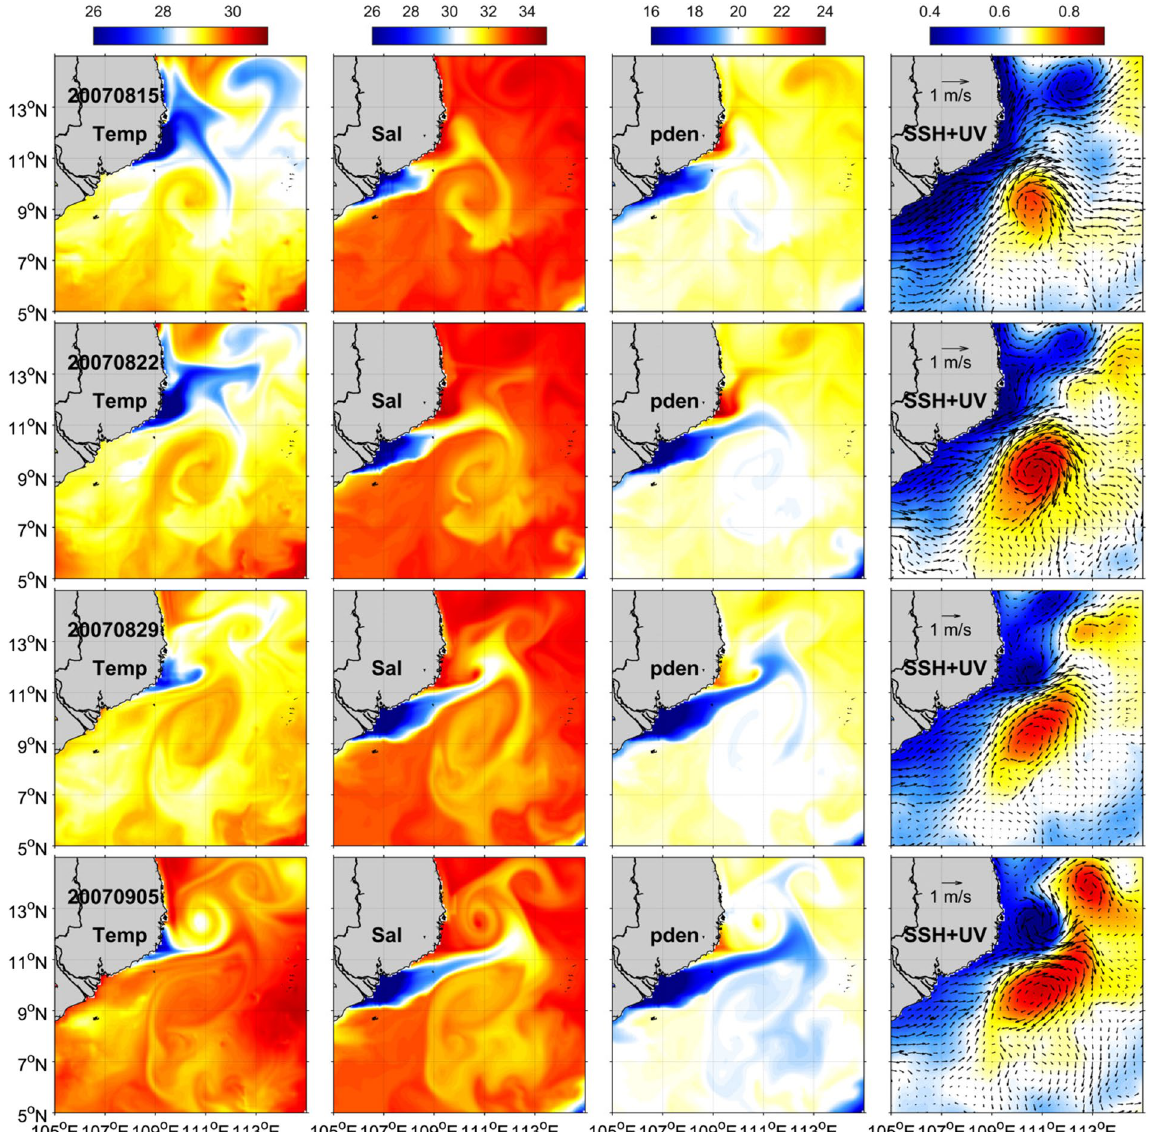
Figure 5. Weekly snapshots of the sea surface thermohaline and circulation patterns. Left to right: sea surface temperature (ºC), salinity, potential density σ θ (kg m − 3 ) and sea surface height (color; with current vectors superimposed). Each row is for a particular date which is labelled in the leftmost panel. The figure is generated using Matlab R2011a (www.mathworks.com/) with m_map package